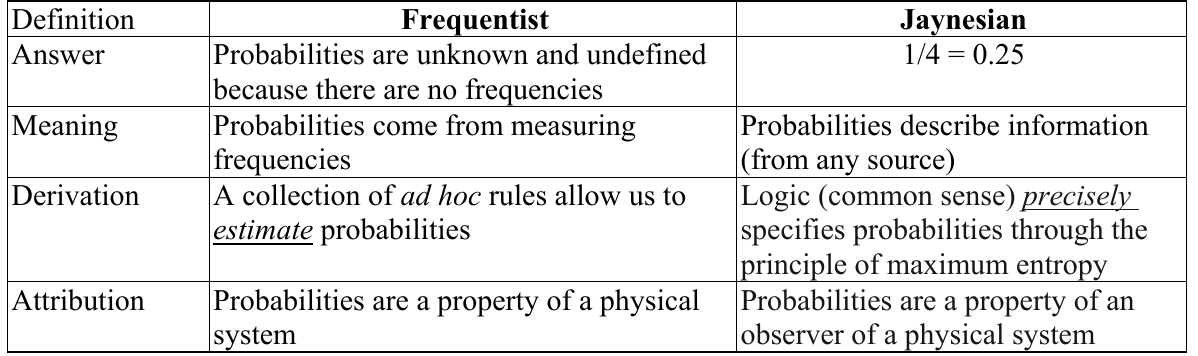
Table 1. Two definitions of probability. These can be illustrated by the following scenario: There are four mutually exclusive possibilities, A, B, C, and D. What is the probability of